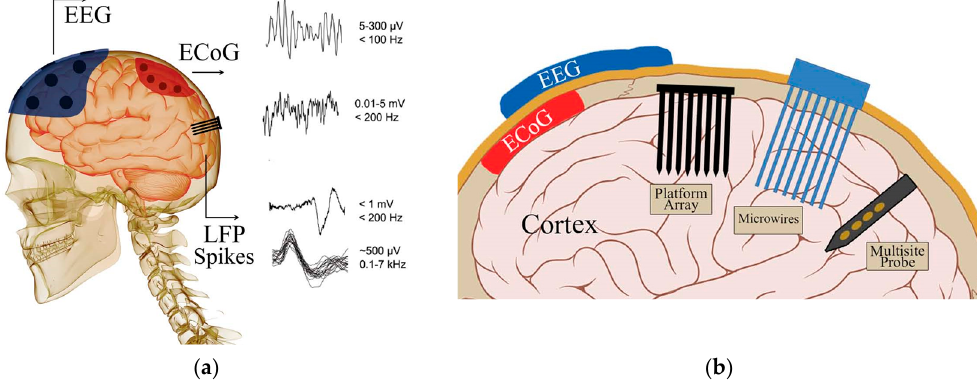
Figure 1. ( a ) Schematic of neural signals (EEGs, ECoGs, LFPs and spikes) and their properties; ( b ) Schematic of EEG electrode on the skull, ECoG electrode on the surface of brain and penetrating electrodes. Reproduced with permission from [42], Wiley, copyright 2014.